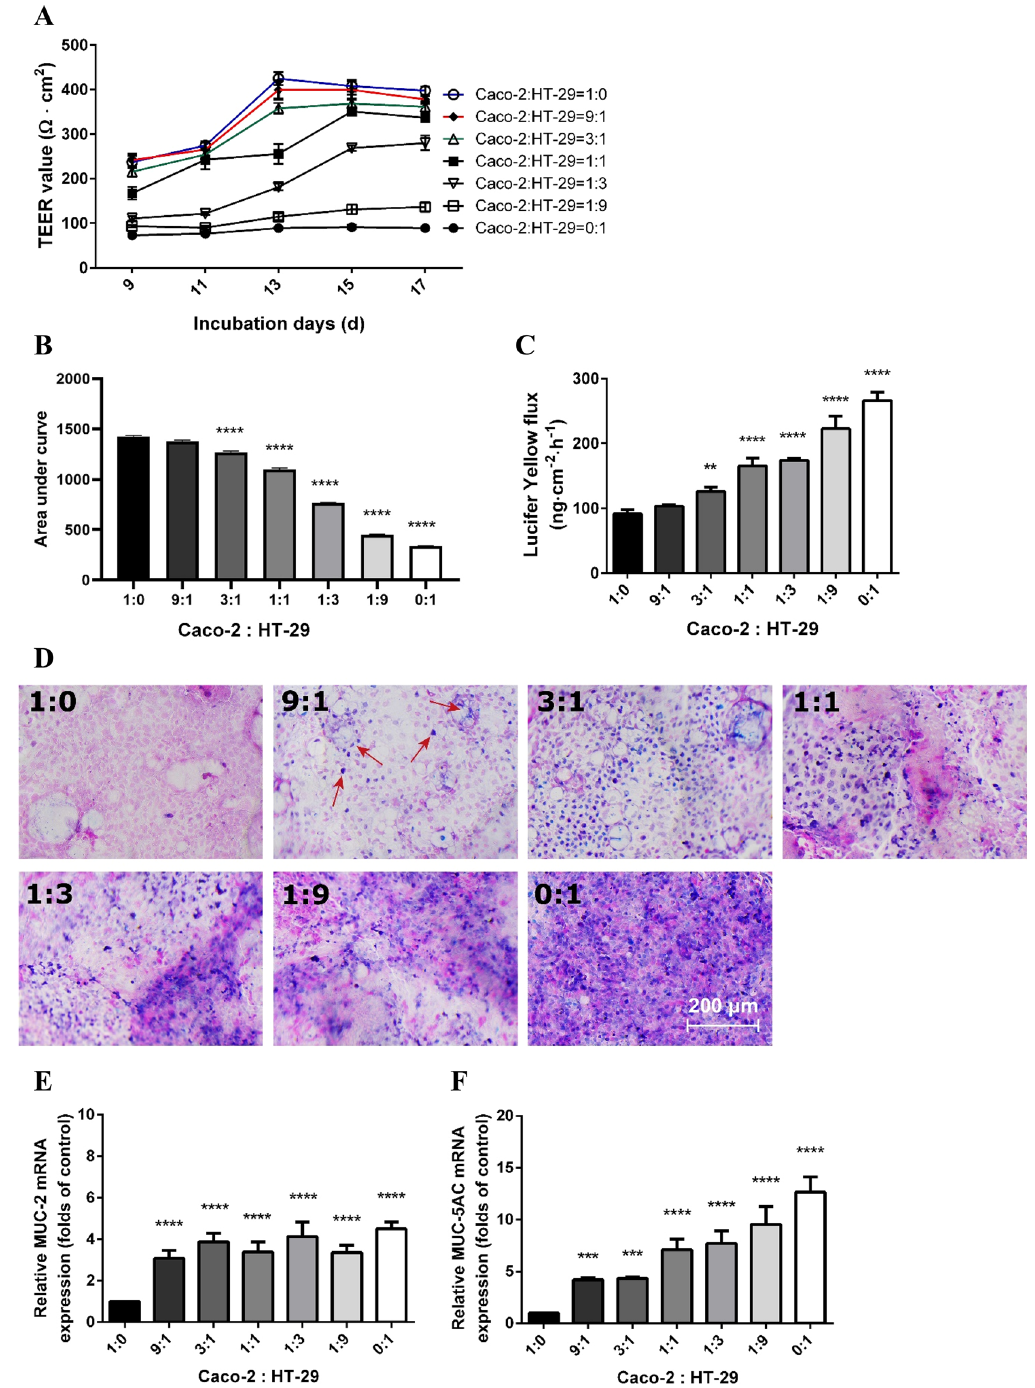
Figure 1. The monolayer integrity and mucus expression in the co-culture model at different ratios of Caco-2 and HT-29 cells. ( A ) TEER values of the cells grown on Transwell membranes. The cell cultures were subjected to TEER evaluation every other day since day 9. ( B ) Areas under the curves of TEER values of the co-culture monolayer calculated for statistical analysis. ( C ) Lucifer Yellow permeability assay of different combinations of Caco-2 and HT-29 cells at day 17. ( D ) Alcian Blue/nuclear fast red staining on Transwell membranes acquired by Nikon Plan 10 × /0.25 objective lens. Pink areas indicated nuclei and blue/purple areas indicated deposition of mucus. Mucin-related mRNA MUC-2 ( E ) and MUC-5AC ( F ) levels assessed by qRT-PCR. The target genes were normalized with reference gene β-actin. All values were presented as means ± SEM (N = 3, n = 3). Statistical differences were analyzed by Two-way analysis of variance (ANOVA), with Bonferroni post-hoc test. ** p < 0.01, *** p < 0.001, **** p < 0.0001; significant different from Caco-2:HT-29 = 1:0